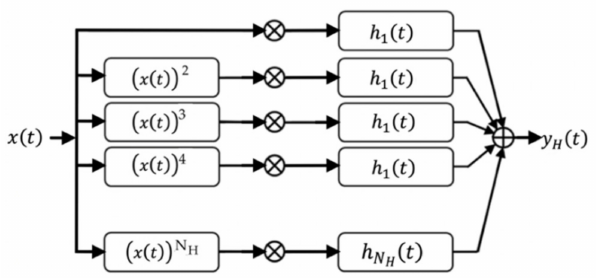
Figure 1. The Hammerstein model. The input x ( t ) and each of its powers up to order N H pass through a different linear filter: ( x ( t )) k is convolved with h k ( t ) . The order N H and the kernels h k ( t ) completely characterize the